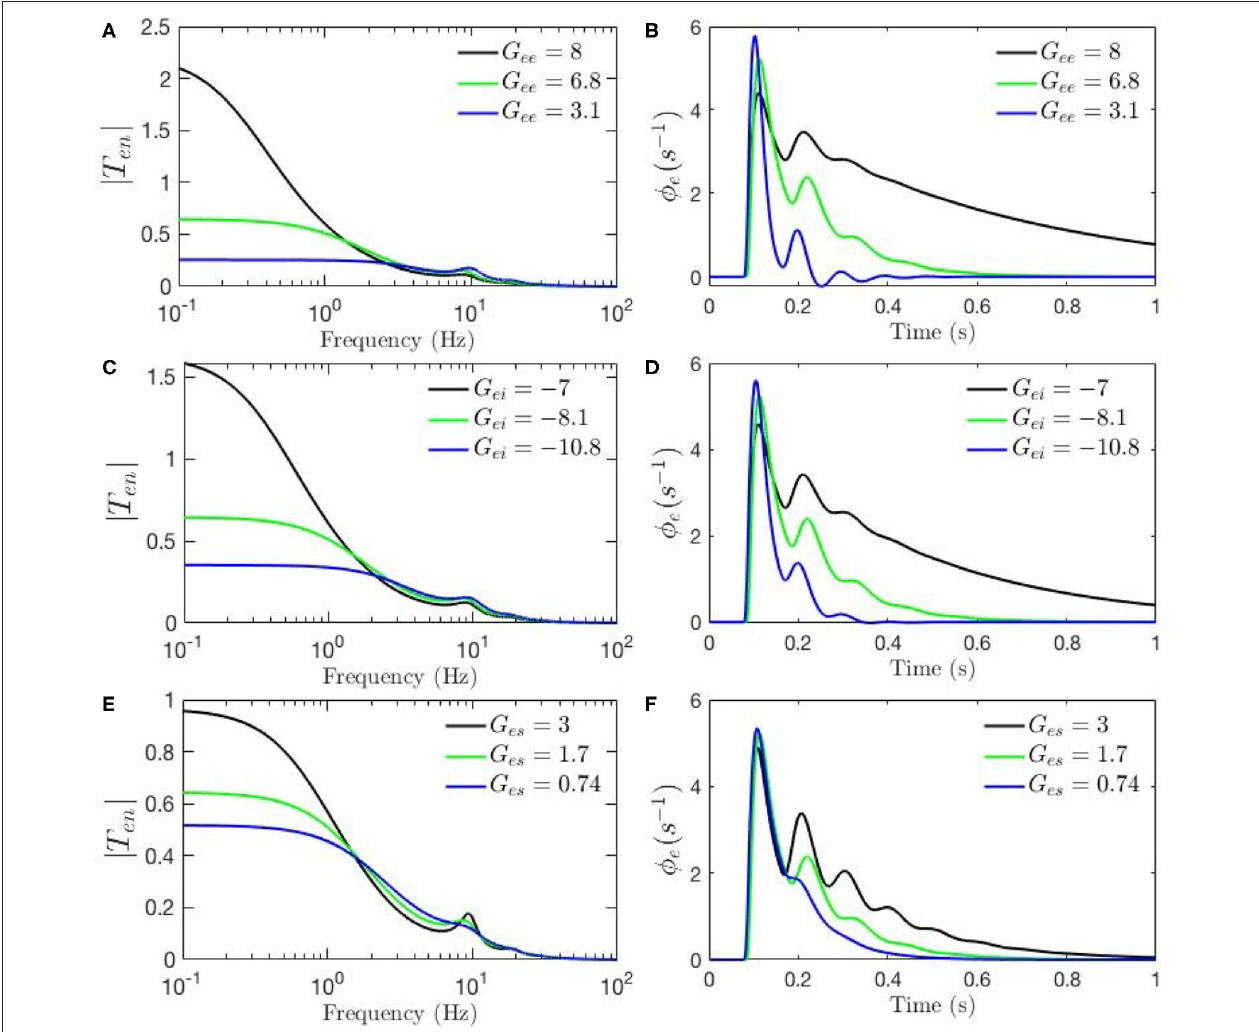
Table 1 , and then in the opposite direction relative to the EEG values (green). The parameters varied are as follows, with the transfer function T in the left column of each row and the corresponding ERP in the right column: (A,B) G ee . (C,D) G ei . (E,F) G es .